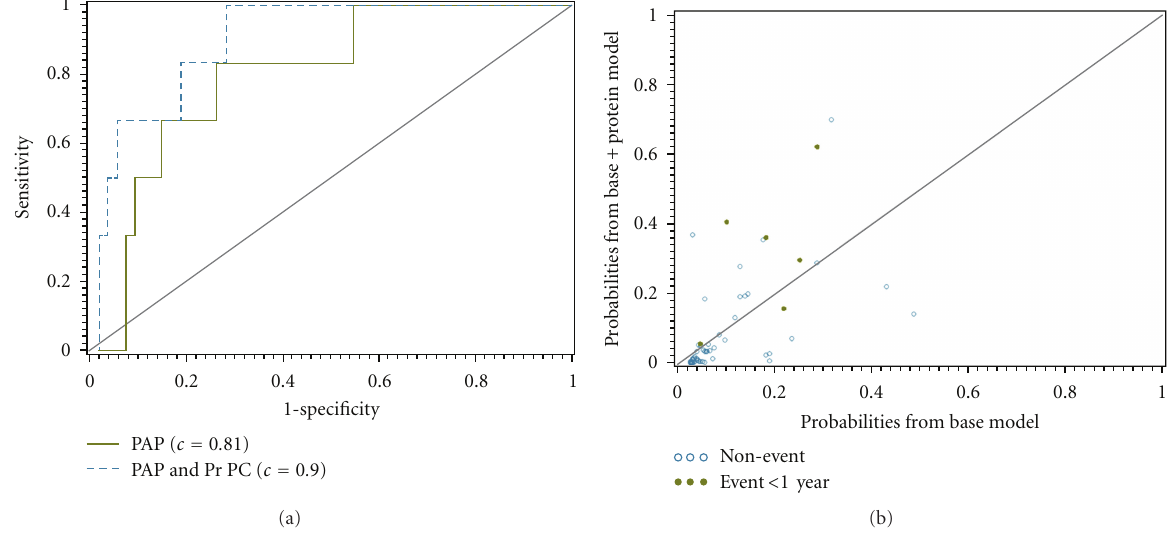
Figure 3: Added value of proteins toward outcome prediction. (a) Comparison of the ROC curves indicate an improvement in discriminative ability with the addition of the 4th PC calculated from the protein measurements. c -indices for each model are also displayed. (b) The reclassification of estimated probabilities for the logistic regression model which included protein markers as a predictor versus the model based on PAP alone. The dots represent those observations associated with an event and the open circles with a nonevent. Higher percentages of events and nonevents are desired above and below the reference line, respectively. The corresponding reclassification index was significant ( P = 0 . 01) indicating a significant improvement in prediction with the addition of the